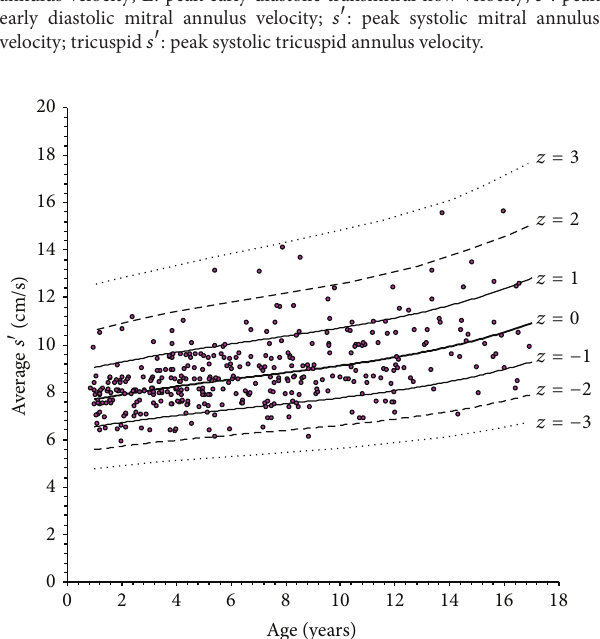
Figure 2: Scatterplot of peak systolic left ventricular longitudinal velocity ( 𝑠 󸀠 ) versus age. In this figure and in the successive ones, the solid line represents the estimated regression equation (indicated as 𝑧 = 0 ). The other lines represent the ± 1, ± 2, and ± 1 𝑧 values above and below the regression curve.